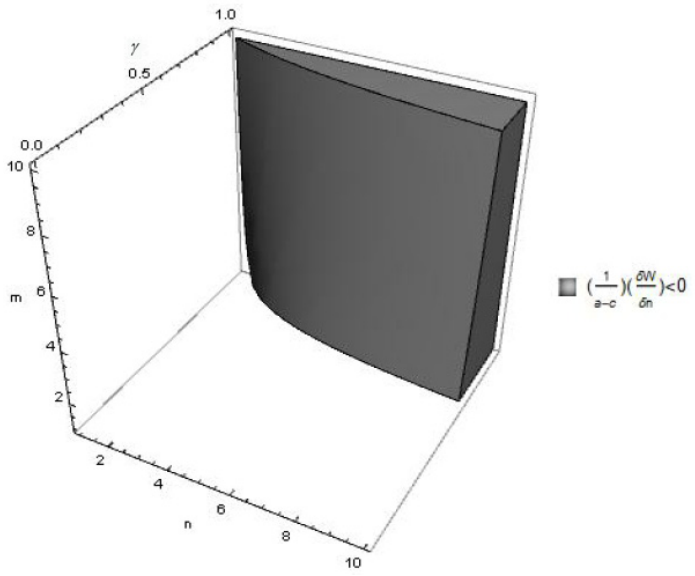
Figure 3. (cid:2869) ((cid:3028)(cid:2879)(cid:3030))(cid:3105)(cid:3024) for 𝑛 ∈ [1,10] , 𝑚 ∈ [1,10] and 𝛾 ∈ [0,1] (cid:3105)(cid:3041) The shaded (white) region in Figure 3 shows